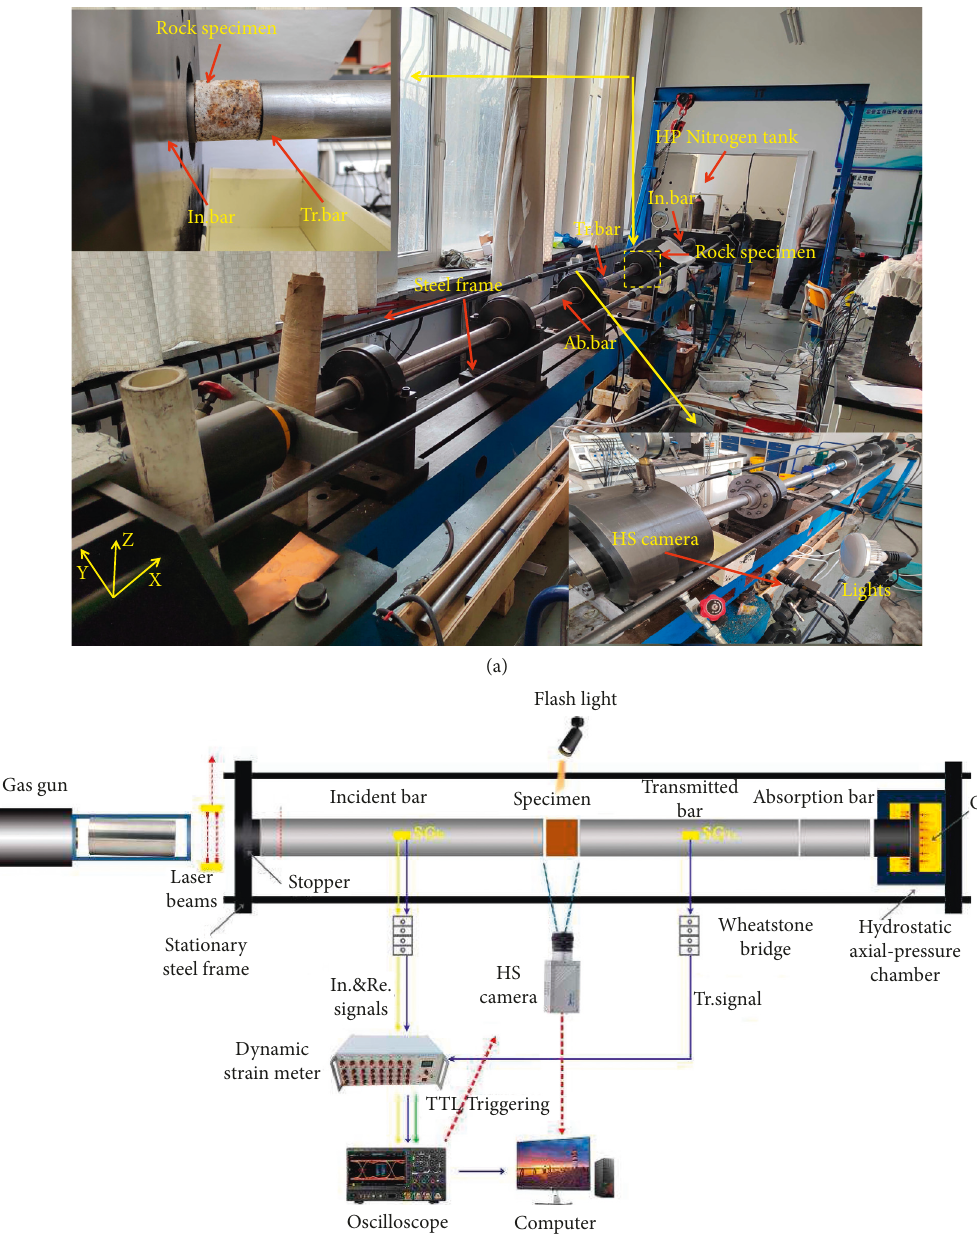
Figure 3: The SHPB test system; (a) photograph of SHPB device; and (b) schematic diagram of SHPB